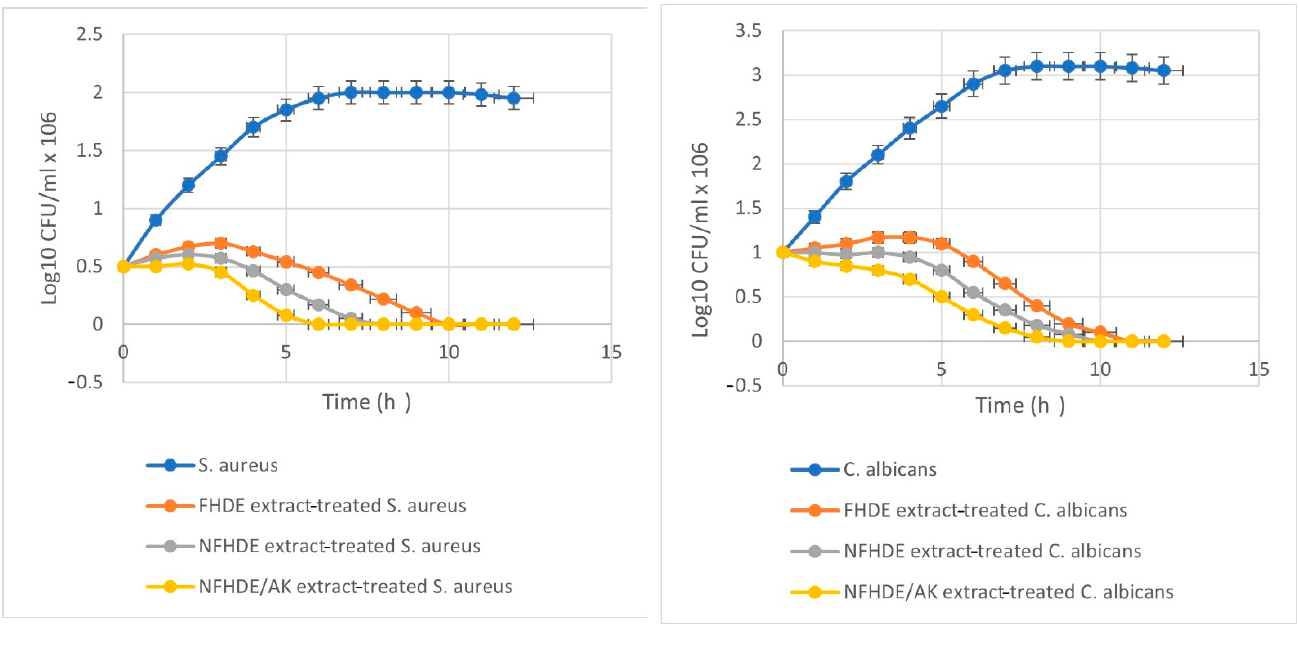
Figure 5. Time kill curve of FHDE and NFHDE/AK extract treated S. aureus ( a ) and C. albicans ( b ) cells.